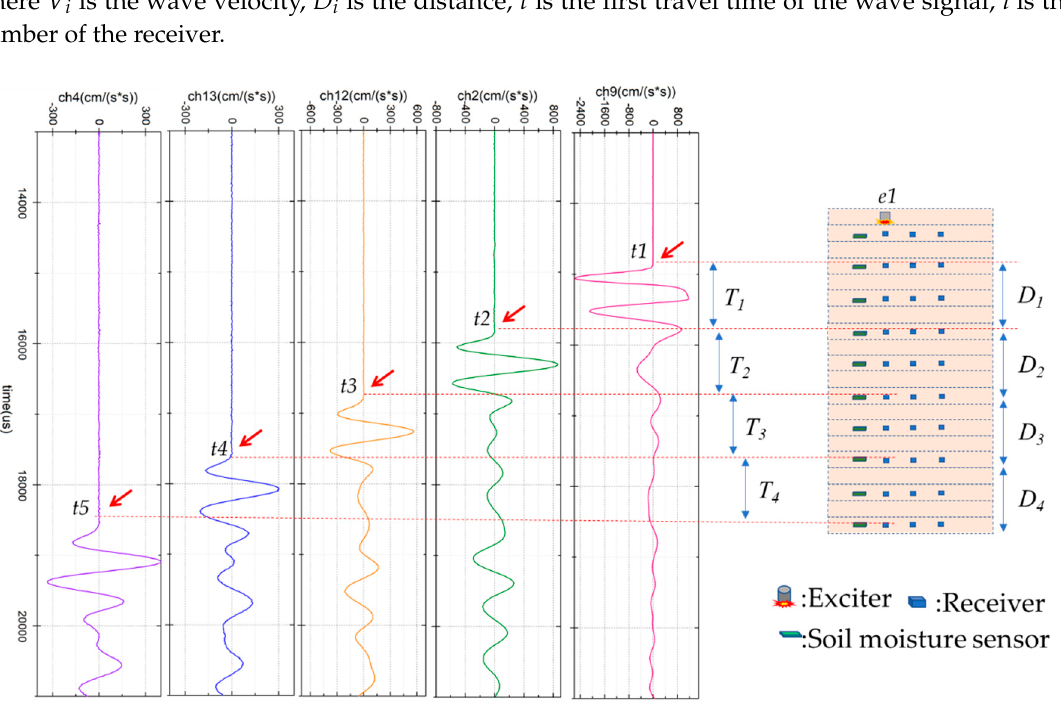
Figure 5. Waveforms and the method to calculate the elastic wave velocity. The wave signal is generated by exciter e1 and detected by receivers in the vertical survey line. The wave velocity is defined by the travel distance divided by the travel time between two receivers. t1~t5 are the first travel times of the wave signals.